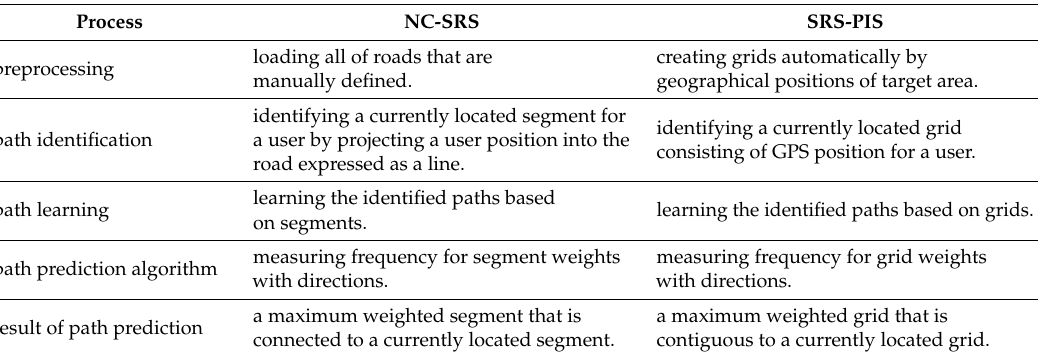
Table 3. The PIS of the NC-SRS and the SRS-PIS